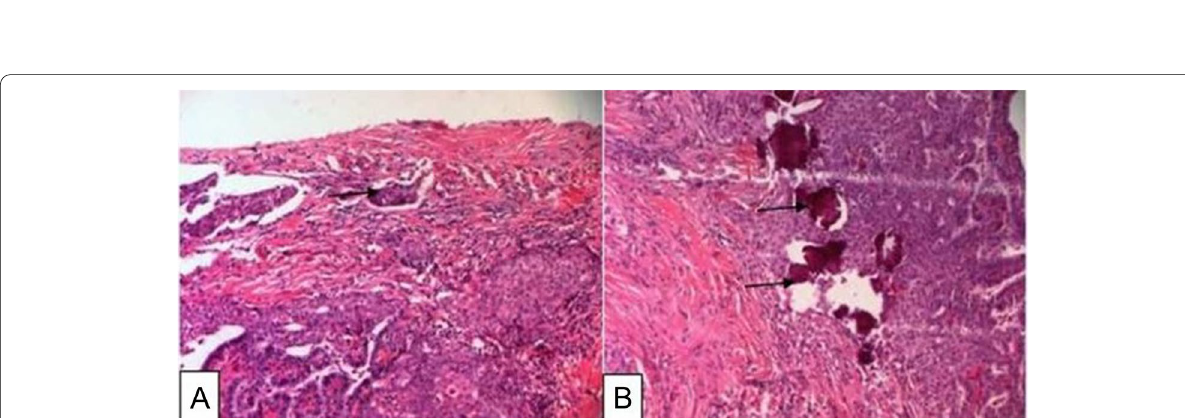
50). B Numerous psammomatous bodies (indicated by an ×